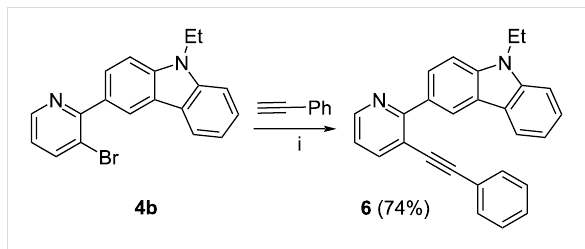
Scheme 3: Sonogashira coupling of compound 4b with phenylacety- lene. i) Pd(PPh 3 ) 2 Cl 2 , CuI, iPr 2 NH, DMSO, 80 °C, 24 h, argon.